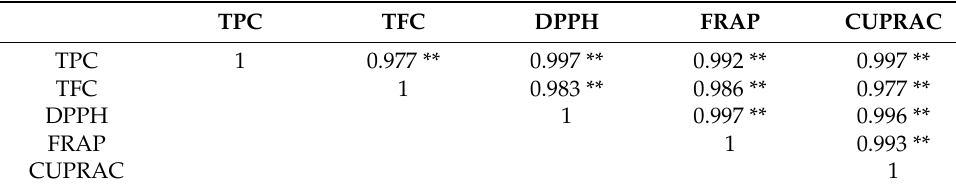
Table 3. Correlation coefficients between TPC, TFC and antioxidant